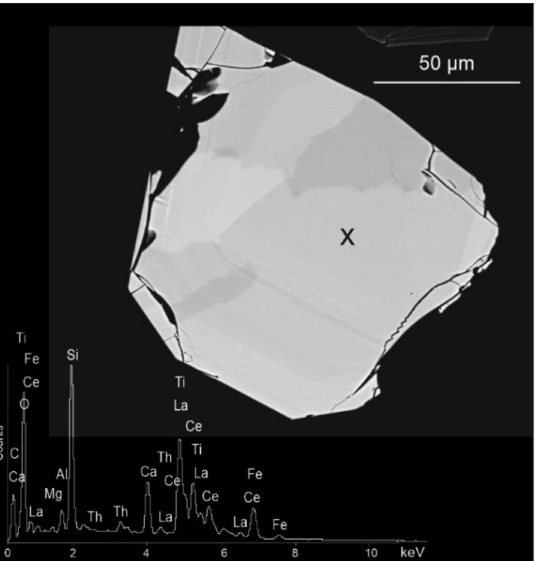
Figure 2. BSE image of a chevkinite crystal with complex growth and alteration-related chemical heterogeneities, and a typical EDS spectrum revealing chemical